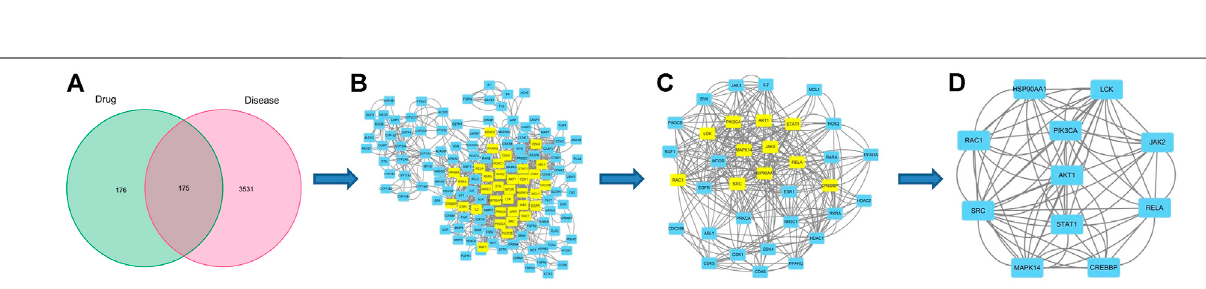
Frontiers in Pharmacology |